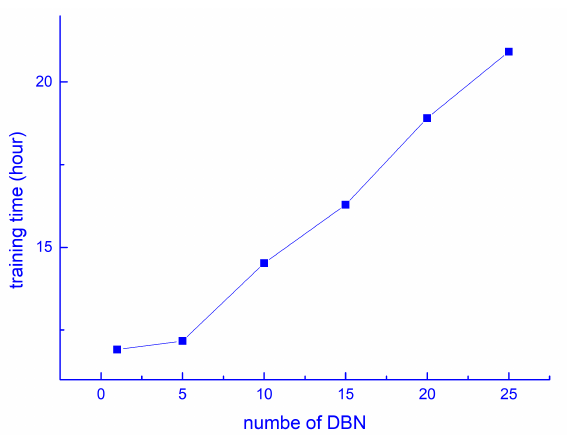
Figure 13. The influence of DBN numbers on performance of training